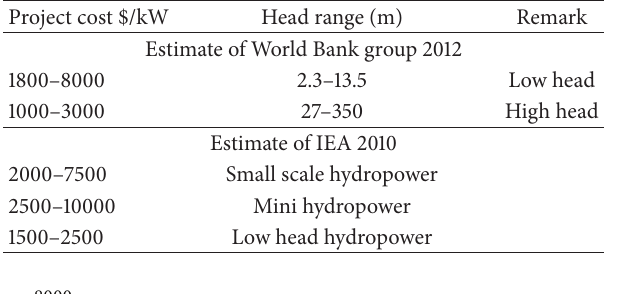
Table 2: World Bank and IEA cost estimate of hydropower [38, 40].